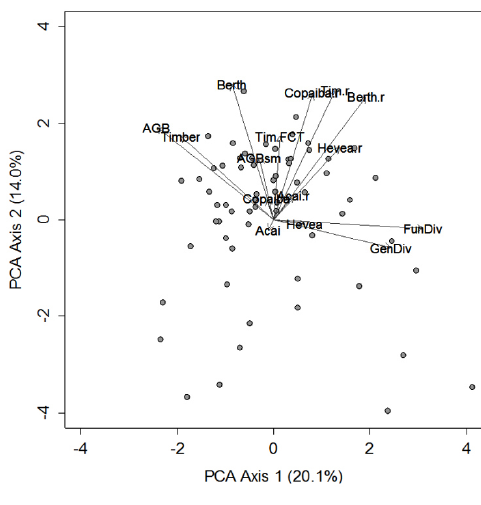
Fig. 2 . Biplot of principal components analysis illustrating correlations among forest value components, which are indicated along arrows using abbreviations from Table 1. Ordinations of the 69 forest sample plots are illustrated as grey circles. See Table 4 for complete results of correlation analyses and principal components analysis (PCA) loadings of forest value components.